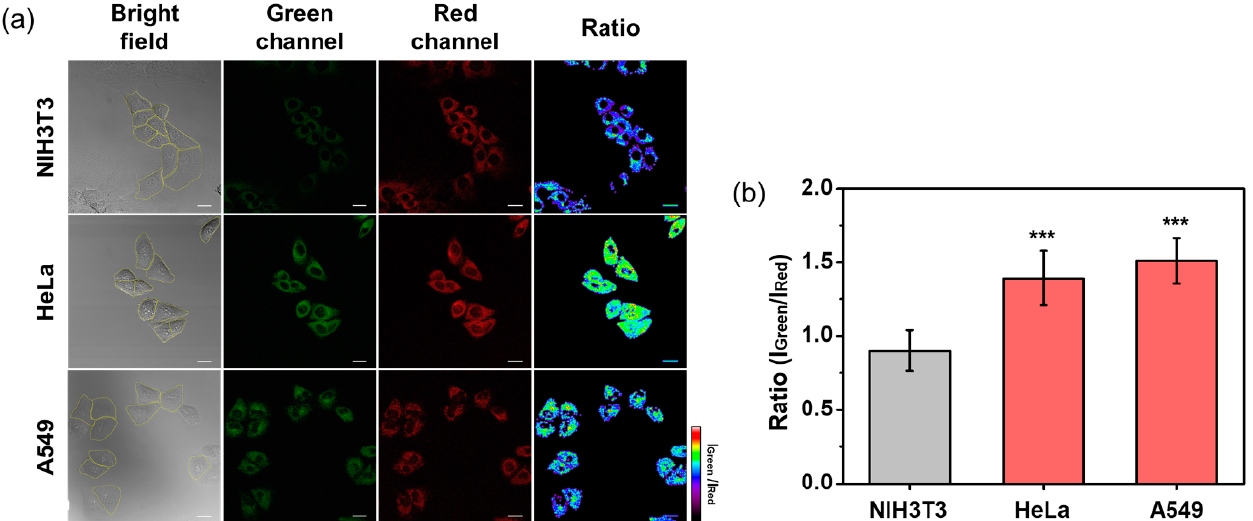
Figure 6. ( a ) Confocal microscopy images for non-cancerous cells (NIH3T3) and cancer cells (HeLa and A549) treated with probe 1 (15 µ M) for 30min, respectively. Images were obtained by adopting an excitation laser at 488 nm with band-pass filters for green (493–550 nm) and red (615–800 nm) channels. Scale bar: 20 µ m. ( b ) Quantification of the fluorescence intensity ratio in the cells. Fluorescence intensities were quantified from the cells (yellow circles, cell counts = 10) in the image by an ImageJ software. Error bars displayed mean ± standard deviation. Asterisks indicate statistically significant changes (*** p value<